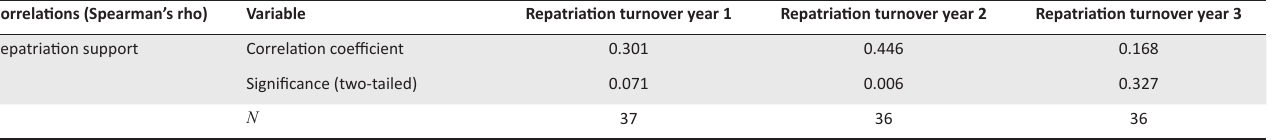
TABLE 13: Repatriation support and repatriation turnover rates. Correlations (Spearman’s rho)